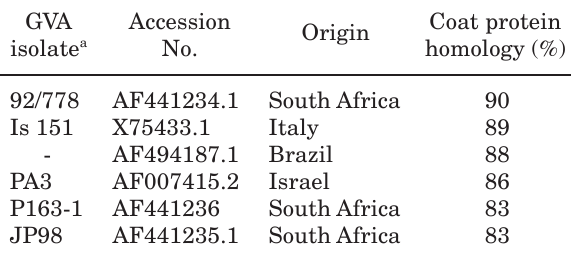
Table 2. Nucleotide sequence homology of the coat pro- tein gene of the Jordanian isolate of grapevine virus A with isolates from other